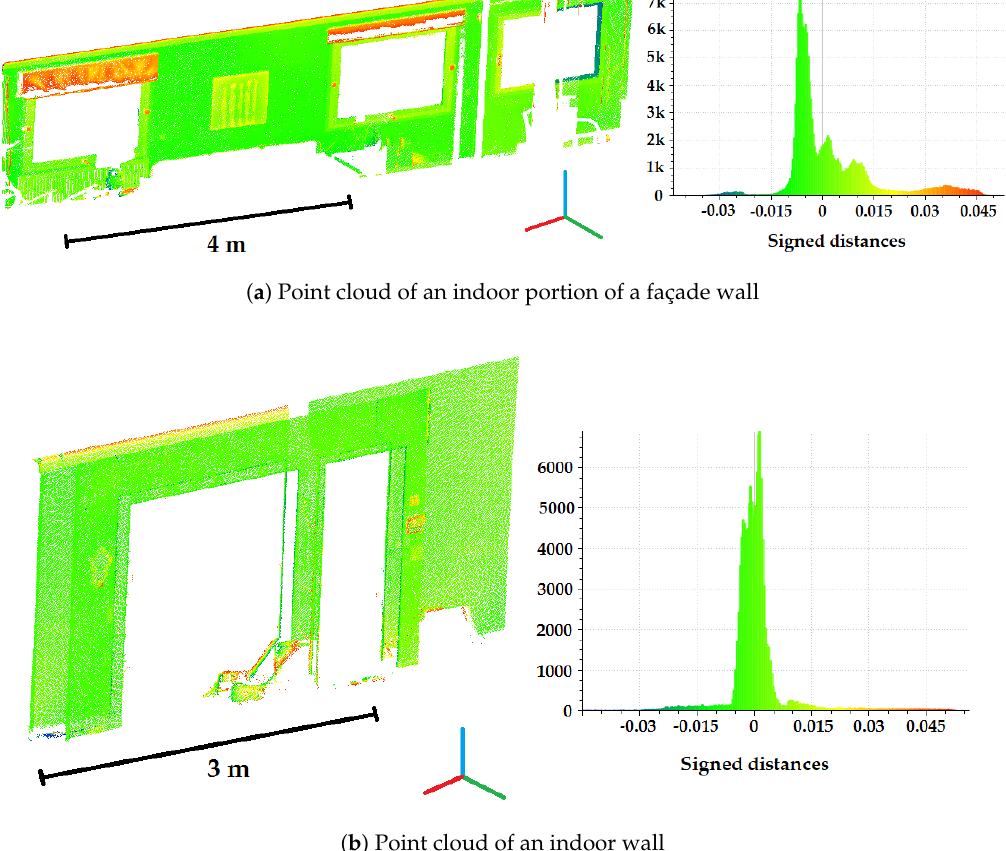
Figure 17. Point clouds colourized with points-to-model signed distances: ( a ) For a surface. ( b ) For a